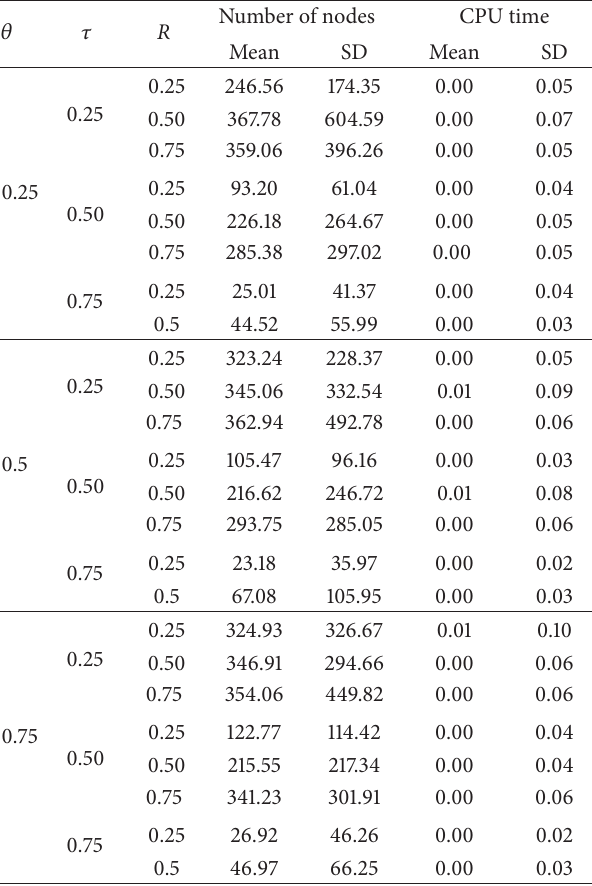
Table 1: The performance of the B&B with 𝑛 = 12 and 𝜃 = 0.5 . P